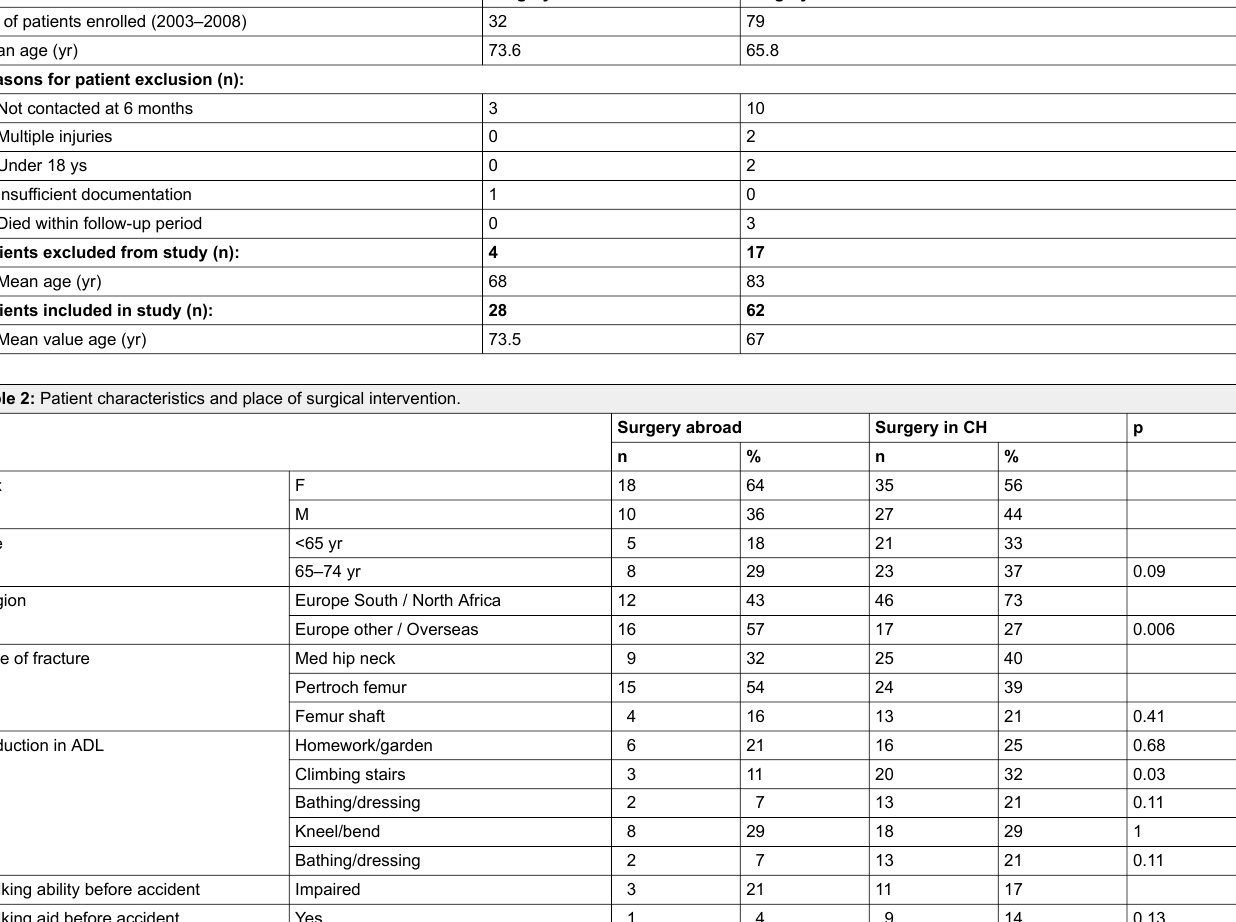
Table 1: Patient groups and reasons for patient exclusion.